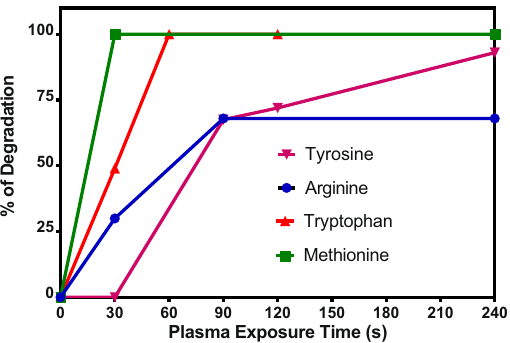
Figure 11. Percentage of degradation of amino acids (0.2 mM) in water after He plasma treatment at various exposure time. The percentage of degradation of each amino acid for an exposure time to He plasma was determined by the following ratio [x − y]/x; where x corresponds to the intensity of the mass peak of the amino acid before treatment and y to the intensity after exposure to He